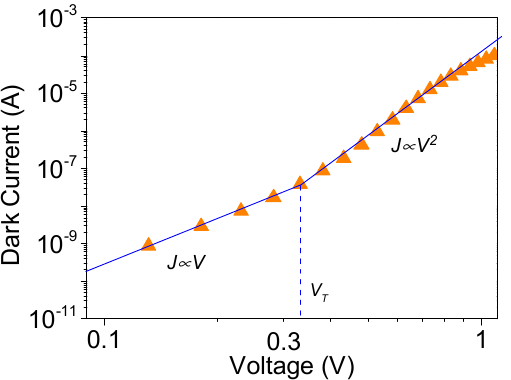
Figure 3. Double logarithmic plot of the dark current vs. voltage characteristic of a typical Si / GaN NW / P3HT:PC 71 BM structure. For comparison, J ∝ V and J ∝ V 2 to V 3 dependences are shown by lines. For lower voltages, the photocurrent (orange triangles) shows ohmic behavior, which turns into a V 2 to V 3 voltage dependence after threshold voltage V T = 0.33